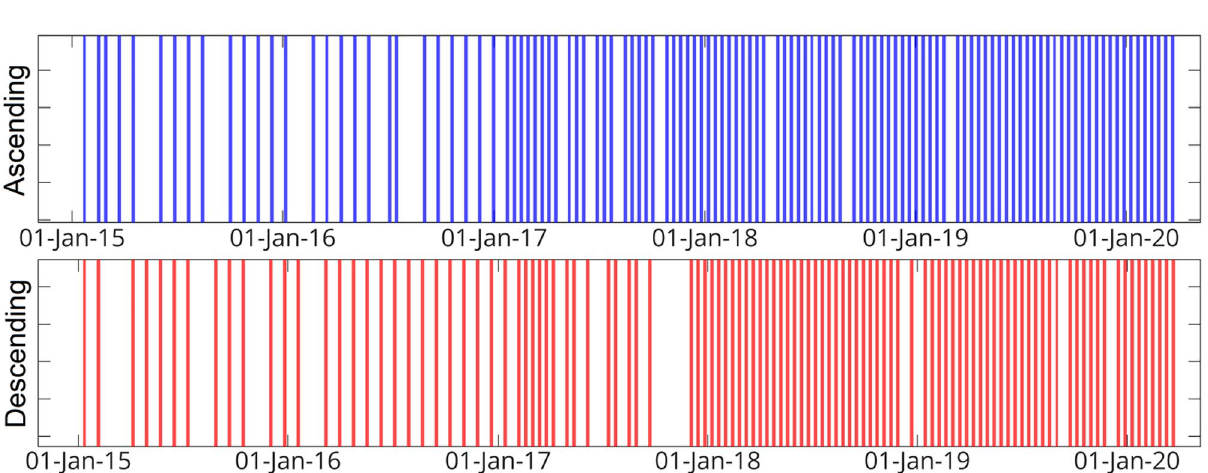
Figure 2. Geological map of the research region (Geological Survey of Iran). This figure was created using the QGIS version Desktop 3.18.1 software (https:// qgis. org/ en/ site/).